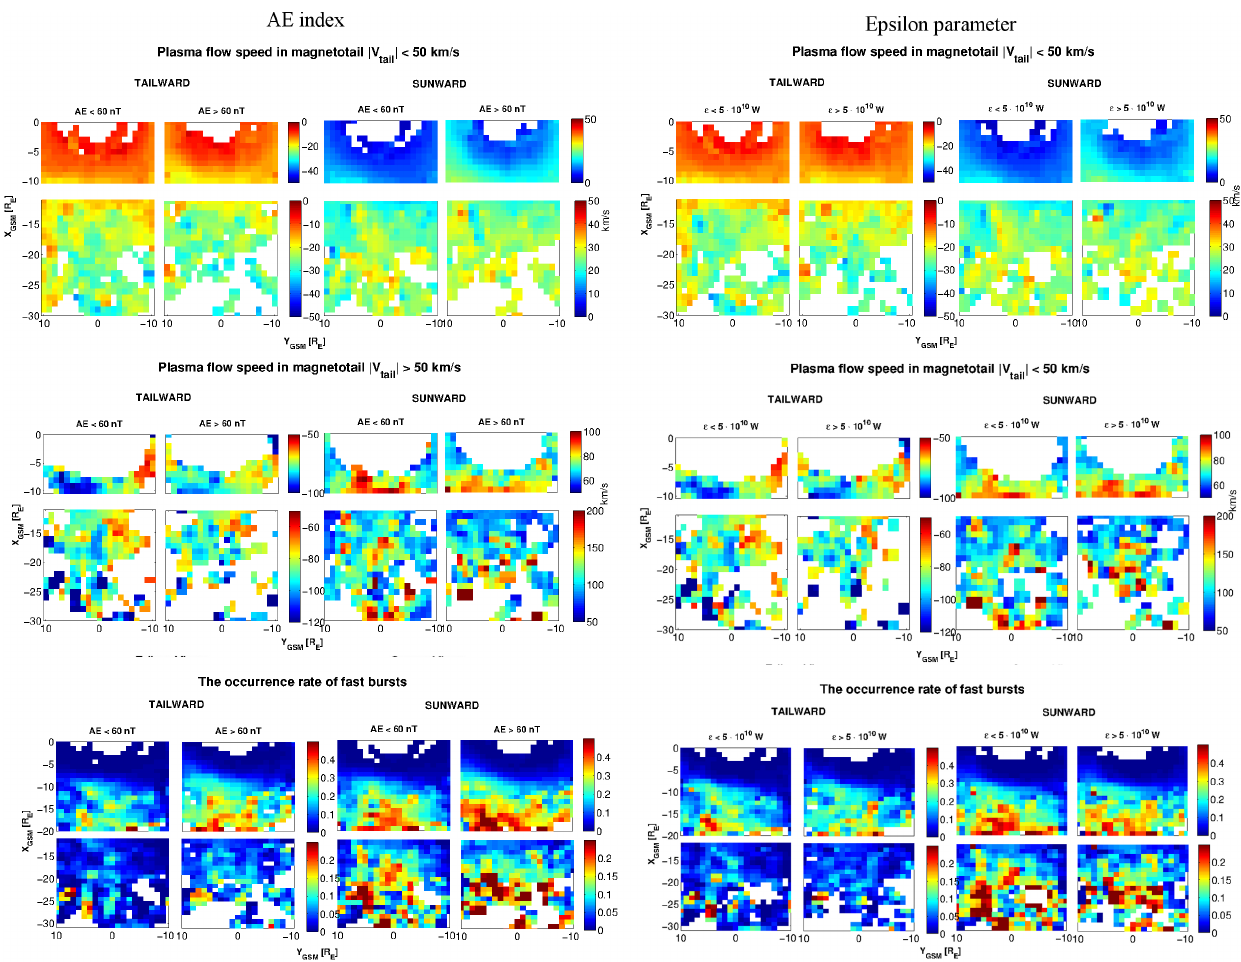
Figure 8. Average plasma flow pattern for slow ( | V tail | < 50kms − 1 , top panels) and fast flows ( | V tail | > 50kms − 1 , middle panels), ratio between the time steps when tail flow bursts exceeded 50kms − 1 (bottom panels, region 0 >X> − 20 R E ) or 100kms − 1 (bottom panels, region − 20 >X> − 30 R E ), and all time steps when the data points are divided into groups based on the AE index and epsilon parameter. The limit for the 1h sliding average AE index and epsilon parameter values are written above the maps. The tailward and sunward flows are shown